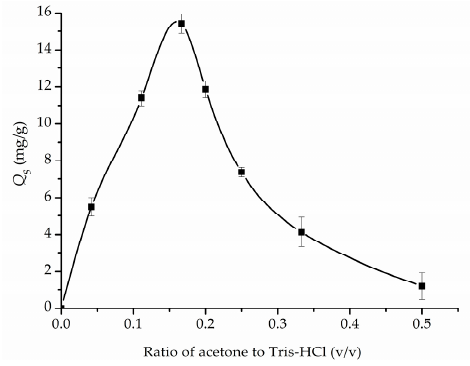
Figure 5. Effect of the ratio of acetone to Tris-HCl buffer ( v / v ) on specific adsorption capacity ( Q s ).